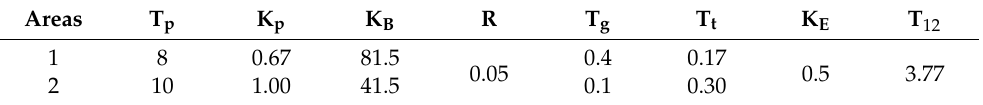
Table 1. Nominal parameters of